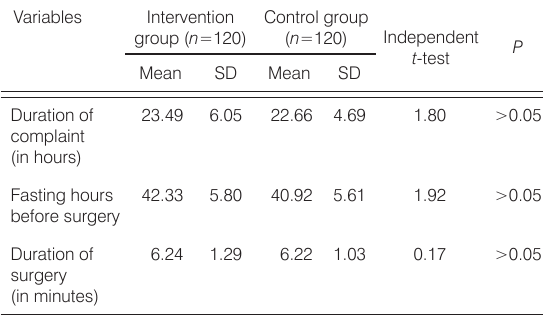
Table 3. Pre- and intraoperative indicators of intervention and control groups.